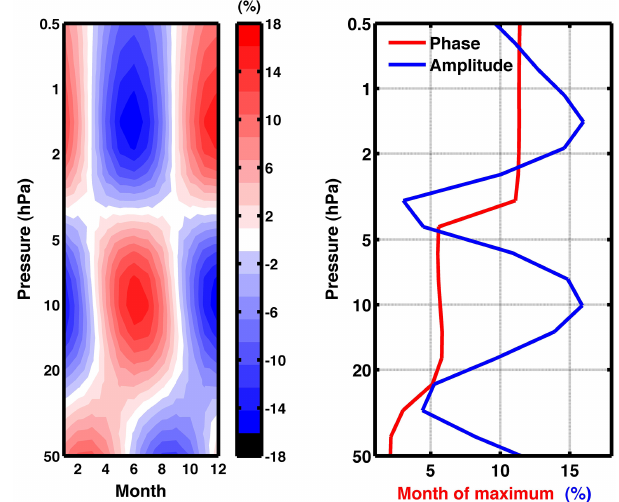
Figure 3. The amplitude of the ozone-AO depending on the months of the year is represented in % in the left panel. The profile of the amplitude of ozone-AO in % (blue line) and its phase given as the month of the maximum (red line) is shown in the right